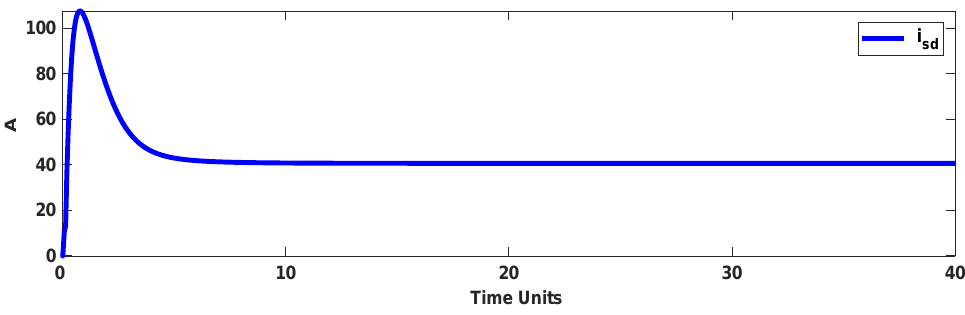
Figure 5. Stator current ( i sd ) in the normal